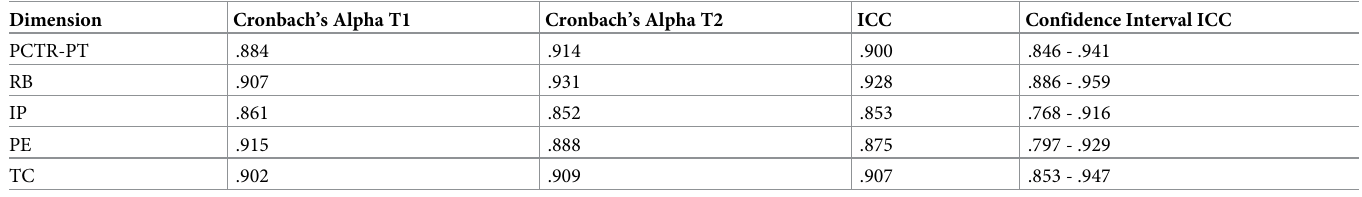
Table 6. Internal consistency: Cronbach’s Alpha for each dimension and after item-reduction (n = 336), test-retest reliability comparing T1 with T2: ICC on scale level (n = 36) of the PCTR-PT.